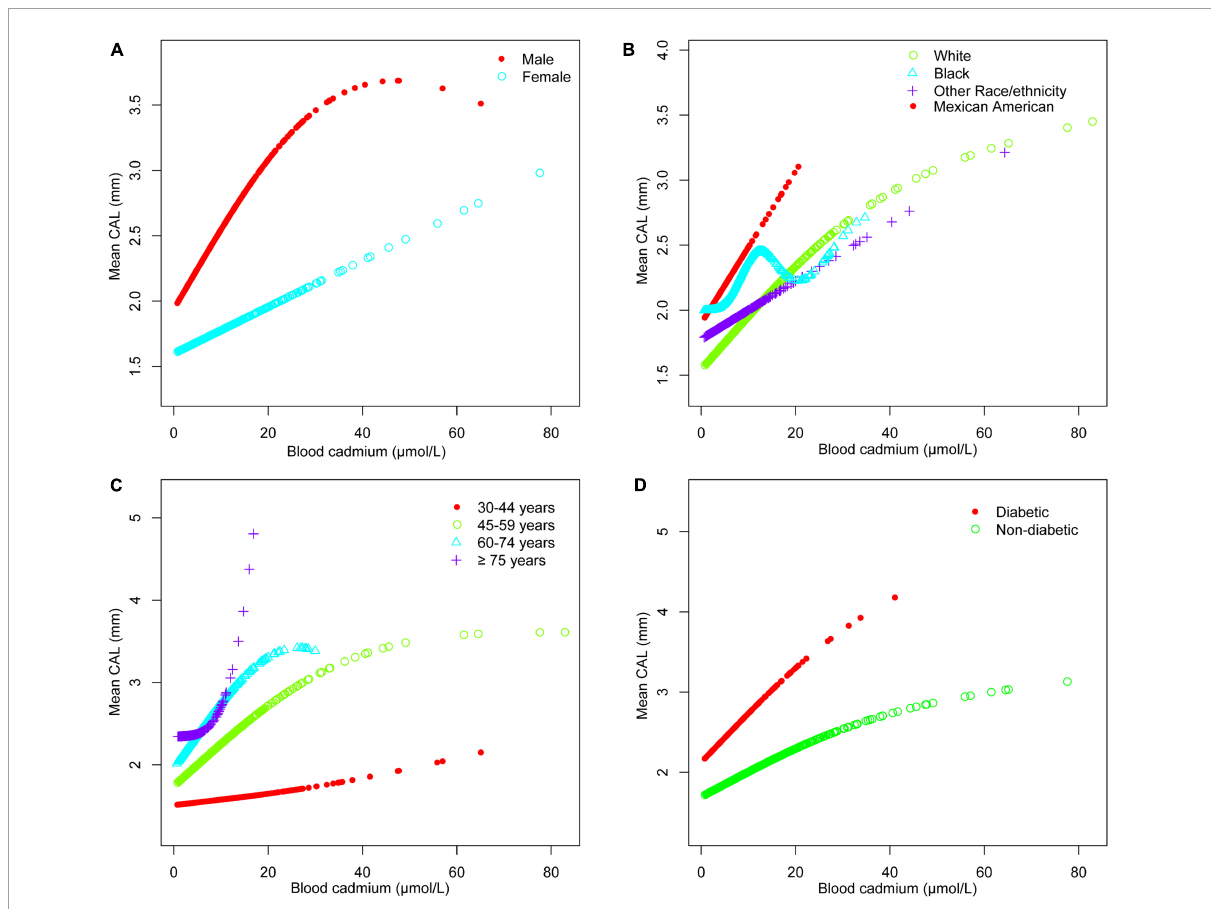
FIGURE4 Blood cadmium and mean CAL dose-response relationship. (A) Stratified by sex. (B) Stratified by race/ethnicity. (C) Stratified by age. (D) Stratified by diabetes history. Age, sex, race/ethnicity, BMI, income-poverty ratio, education, vitamin D, smoking status, diabetes, frequency per week using floss and mouthwash, periodontal treatment, hypertension, hyperlipidemia, BMD, congestive heart failure, coronary heart disease, angina pectoris, heart attack, stroke, physical activity, and calcium intake were adjusted. In the subgroup analysis stratified, the stratification variable itself was not